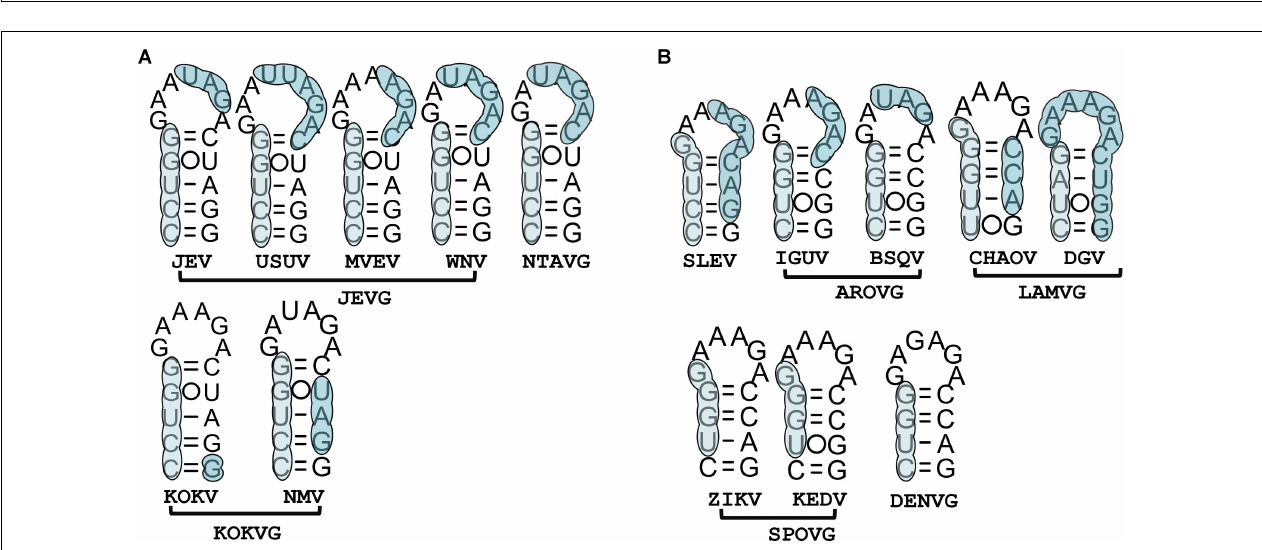
FIGURE 7 | Group-specific 3 (cid:48) sHP characteristic of the overlapping RNA signals. (A) MBFVs comprising the bottom two “C-G”. (B) MBFVs lacking for the bottom two “C-G”. 3 (cid:48) DARI and 3 (cid:48) DARII elements of the overlapping cyclization sequences for each MBFV are annotated in corresponding color as